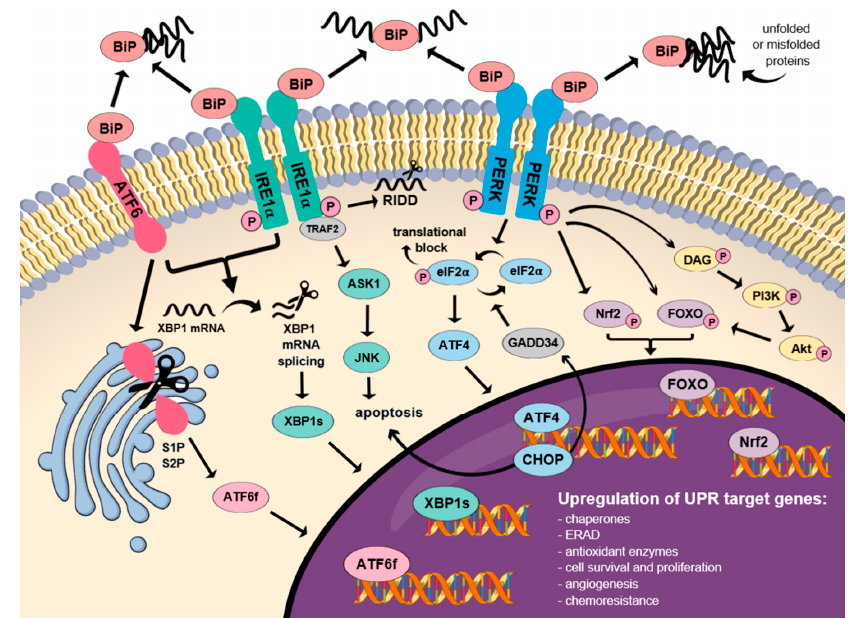
Figure 2. Three major branches of the Unfolded Protein Response (UPR) signaling pathway and their interconnections. Under endoplasmic reticulum (ER) stress conditions, damaged proteins accumulate within the ER lumen and bind to binding immunoglobulin proteins (BiPs), which in turn dissociate from transmembrane complexes with activating transcription factor 6 (ATF6), inositol-requiring enzyme-1 α (IRE1 α ) and the protein kinase R (PKR)-like endoplasmic reticulum kinase (PERK) in attempt to refold the proteins. As a result, three branches of the UPR become activated and trigger adequate stress responses. ATF6, after cleavage in Golgi apparatus, enters the nucleus to activate cytoprotective genes. It also upregulates X-box binding protein 1 (XBP1) mRNA, which is subsequently spliced by IRE1 α to enhance the pro-survival e ff ect. The main downstream target of PERK, eukaryotic translation initiation factor 2 α (eIF2 α ), inhibits the global protein synthesis, with the exclusive translation of specific mRNAs such as activating transcription factor 4 (ATF4). Both nuclear factor-like 2 (Nrf2) and forkhead box protein O1 (FOXO) proteins, directly phosphorylated by PERK, are responsible for antioxidant and cell survival mechanisms. Additionally, PERK may act on FOXO indirectly via phosphoinositide-3 kinase / protein kinase B (PI3K / Akt) signaling pathway. Apoptosis may be induced either by IRE1 α , via c-Jun N-terminal kinases (JNKs) signaling pathway, or by PERK-mediated C / EBP homologous protein transcription factor